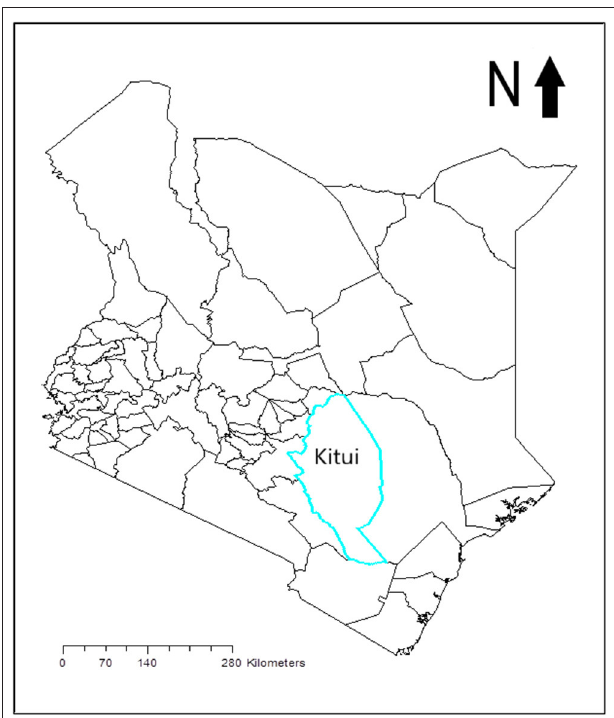
FIGURE 1 | Kitui County in